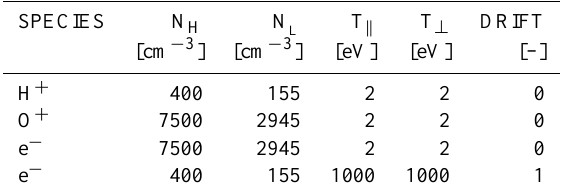
Table 2. The plasma models used in the high (N H ) and low density (N ) cases. Four plasma components are used. The background L plasma is regarded as cold (2eV) and oxygen dominated (O + 95%, H + 5%). In addition, we assume 5% downgoing 1keV inverted- V electrons, whose drift velocity equals the thermal velocity. In Table 2 the drift velocity is normalized to the thermal velocity. The total density is 7900cm − 3 in the high density case and 3100cm − 3 in the low density case. For both cases f H + =514Hz.